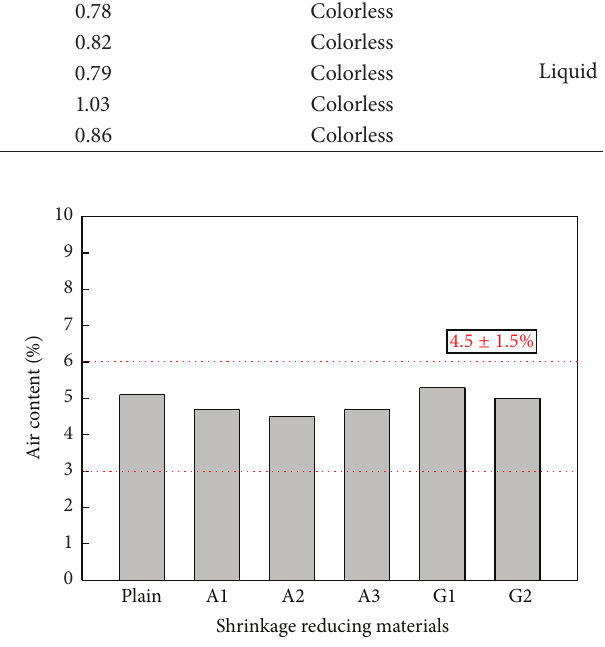
Figure 2: Relationship between air content and shrinkage reducing material.